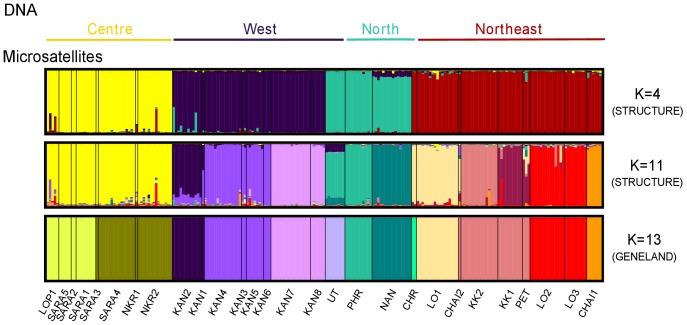
Population structure estimated using STRUCTURE (K = 4, K = 11) and GENELAND (K = 13).Each individual is represented by a vertical line partitioned into K colour segments, the length of each colour being proportional to the estimated membership coefficient.